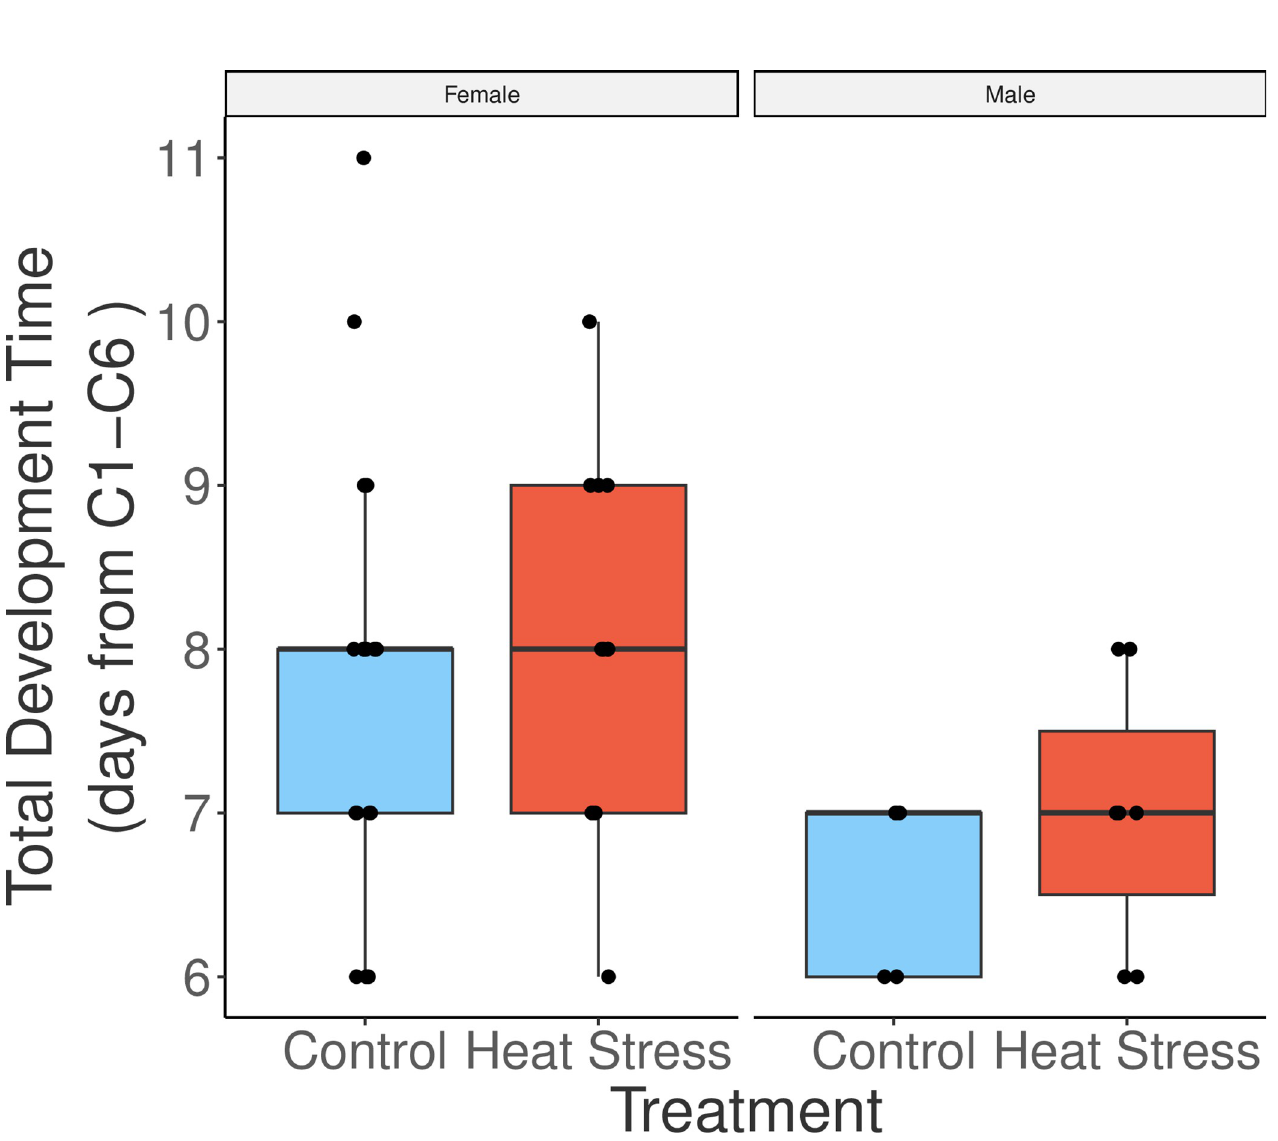
Fig 4. Copepodite development time of male and female Acartia tonsa . Boxplot of total copepodite development time from C1-C6 between experimental groups for both sexes. Box plot components as in Fig 1.